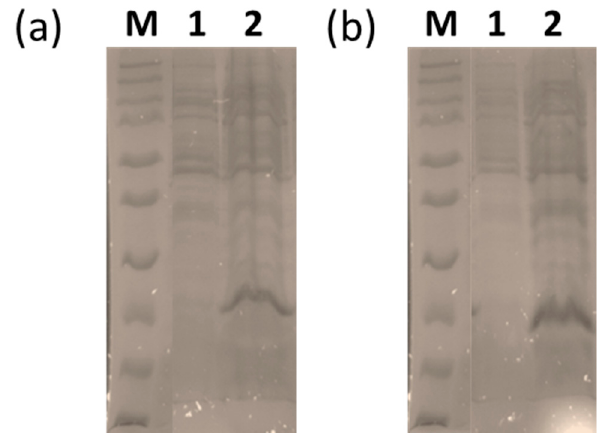
Figure 8. Uninduced and induced cell lysates from E . coli were run on 12% SDS PAGE. ( a ) M-protein marker, lane 1 uninduced PPRVN protein; lane 2 induced PPRVN protein; and ( b ) M-protein marker, lane 1 uninduced DMVN protein; lane 2 induced DMVN protein.